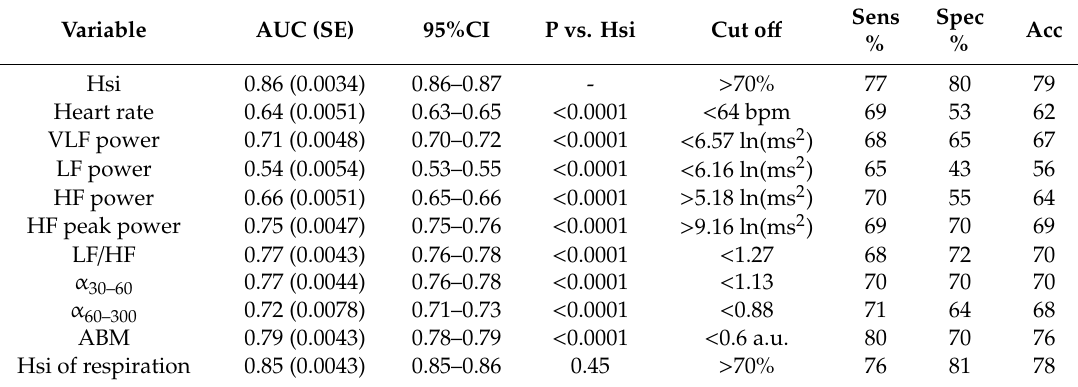
Table 3. Discriminant performance of NREM stage from wake and REM stages per 5-min